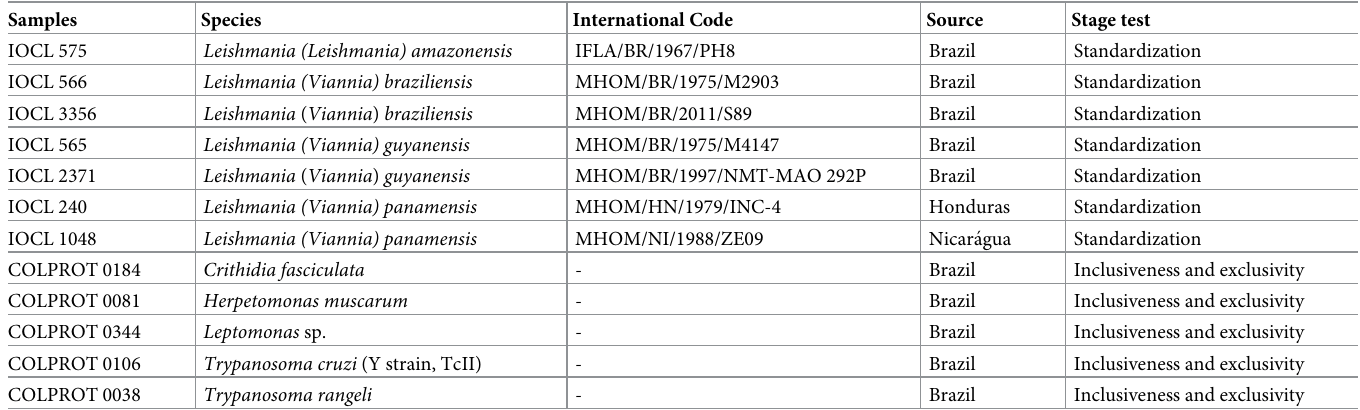
Table 1. Reference strains of Leishmania and other trypanosomatids used in this study. Samples